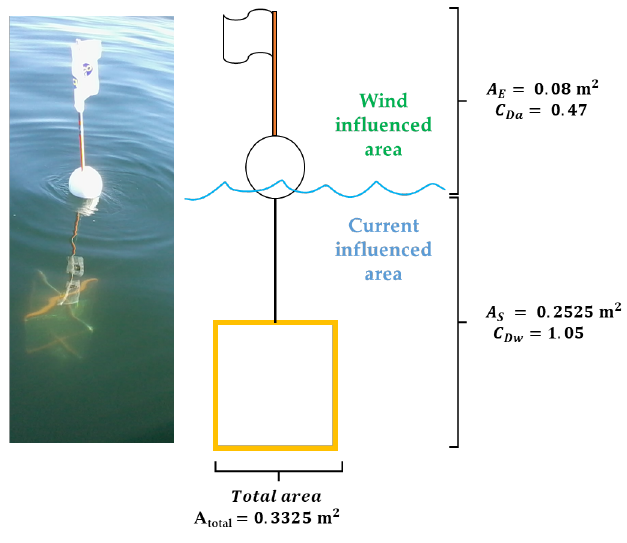
Figure 5. Diagram of drifters released by SHOA (10 and 14 September